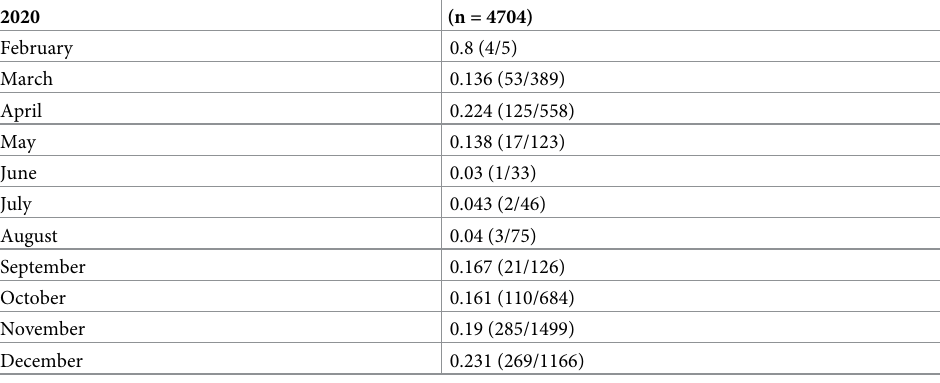
Table 3. In-hospital mortality for each calendar month 2020, complete study cohort (n =